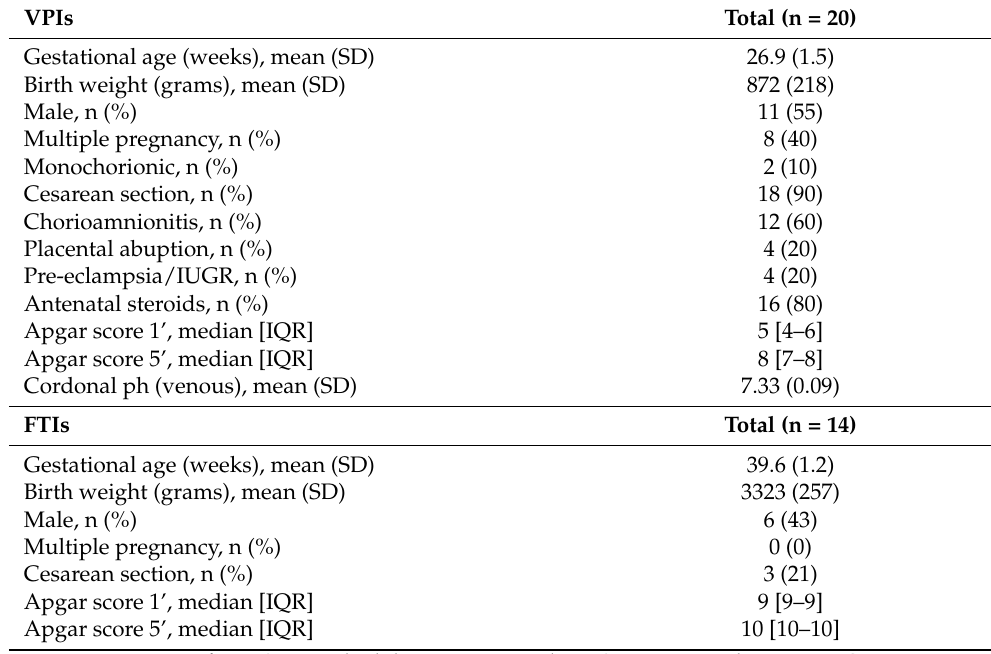
Table 1. Baseline characteristics of the study